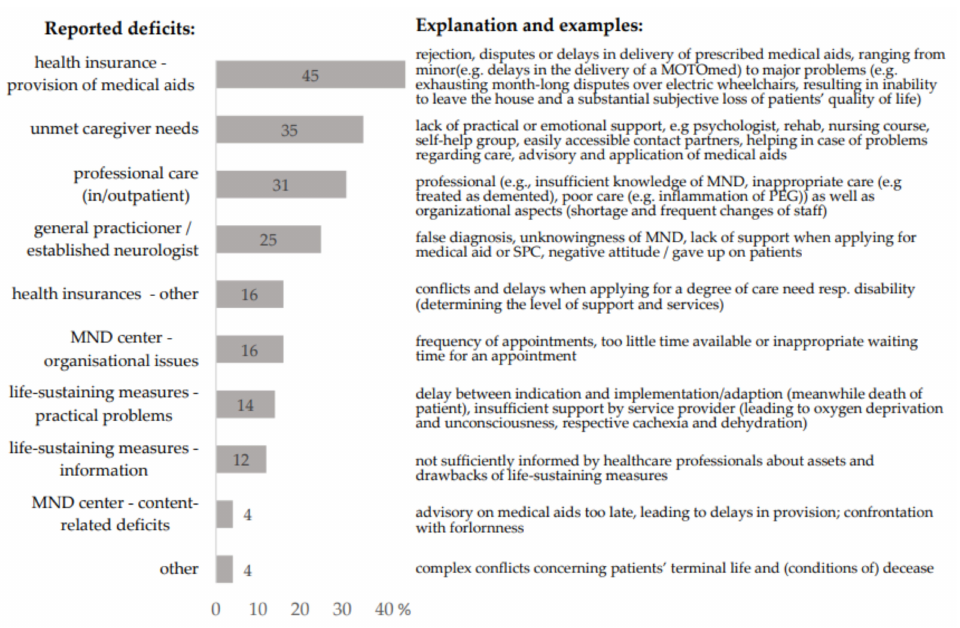
Figure 2. Health problems of caregivers caused or exacerbated by the caregiving situation, as reported by themselves. Data in